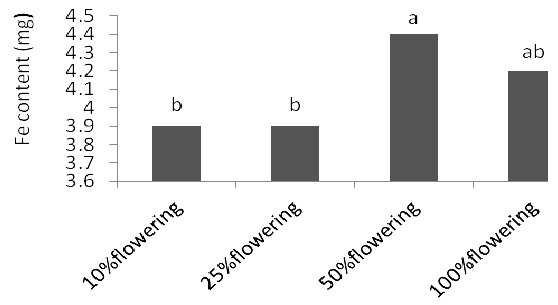
Fig.6. Effect harvest time on Fe